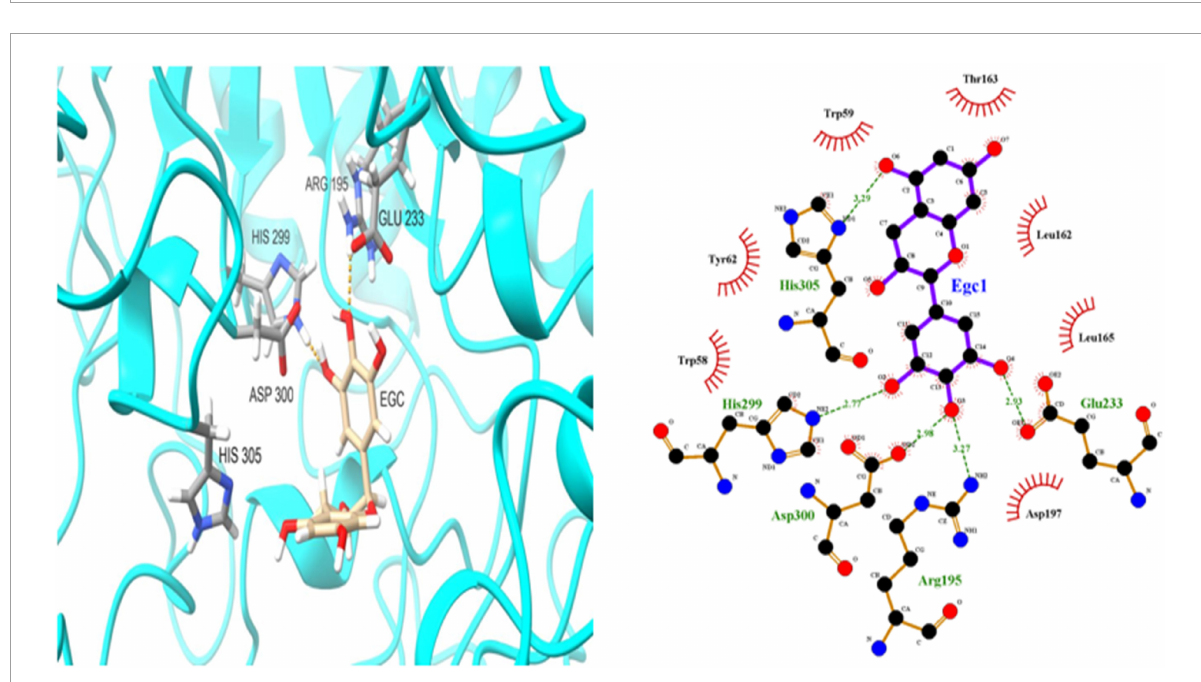
FIGURE7 Molecular docking simulation diagrams of α -amylase and epigallocatechin (in the 2-dimensional graphic, the green dotted line represents the hydrogen bond, and the red arc represents a hydrophobic interaction).